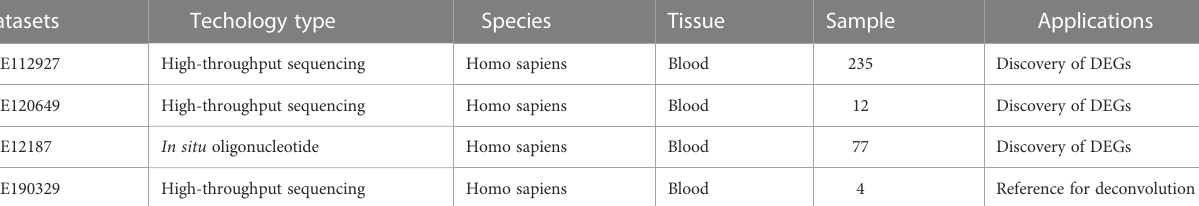
TABLE 1 Details of 4 datasets included in this